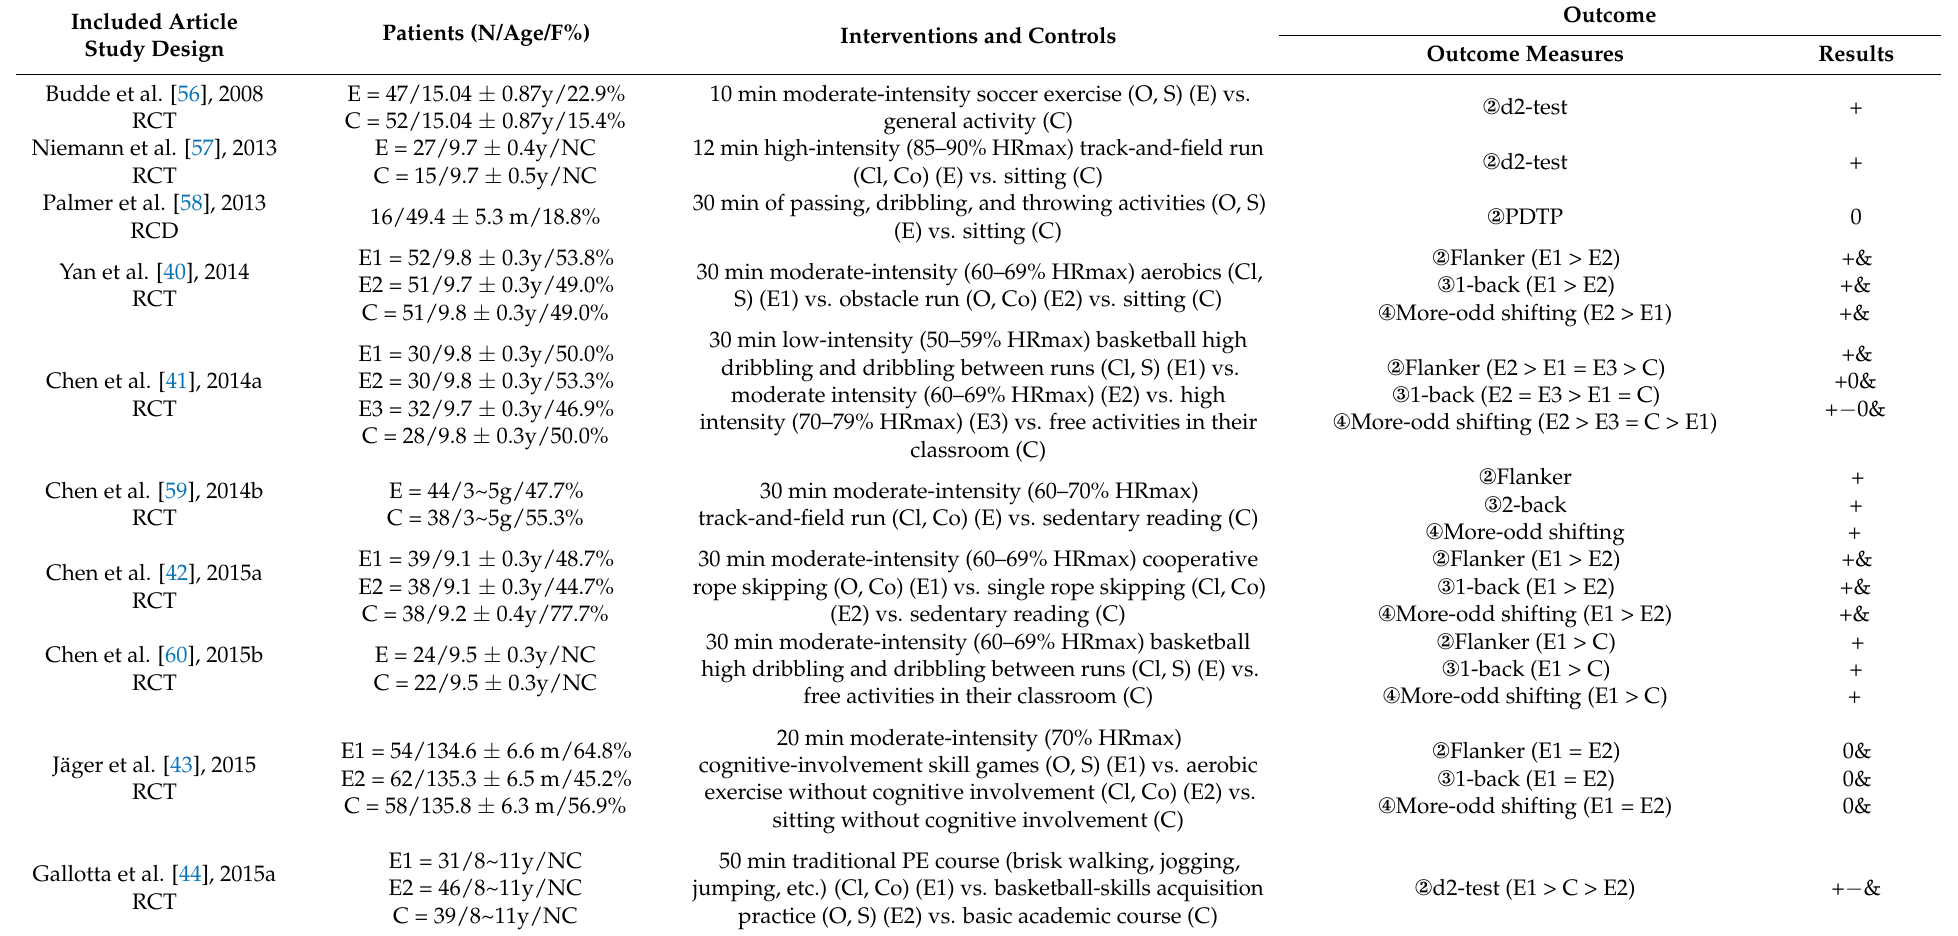
Table 1. Characteristics of included